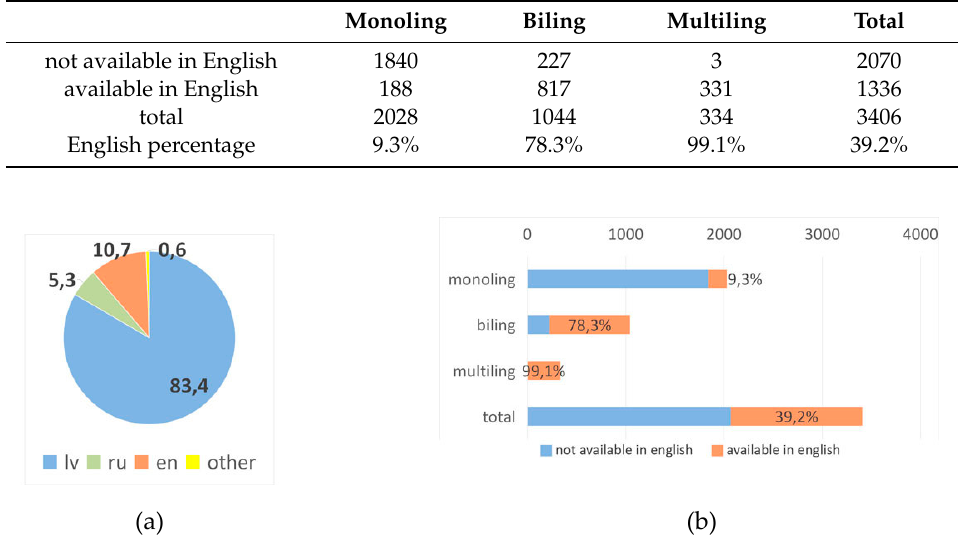
Figure A16. Visualization of the results for domain lv. ( a ) Primary languages pie chart and ( b ) English language availability bar